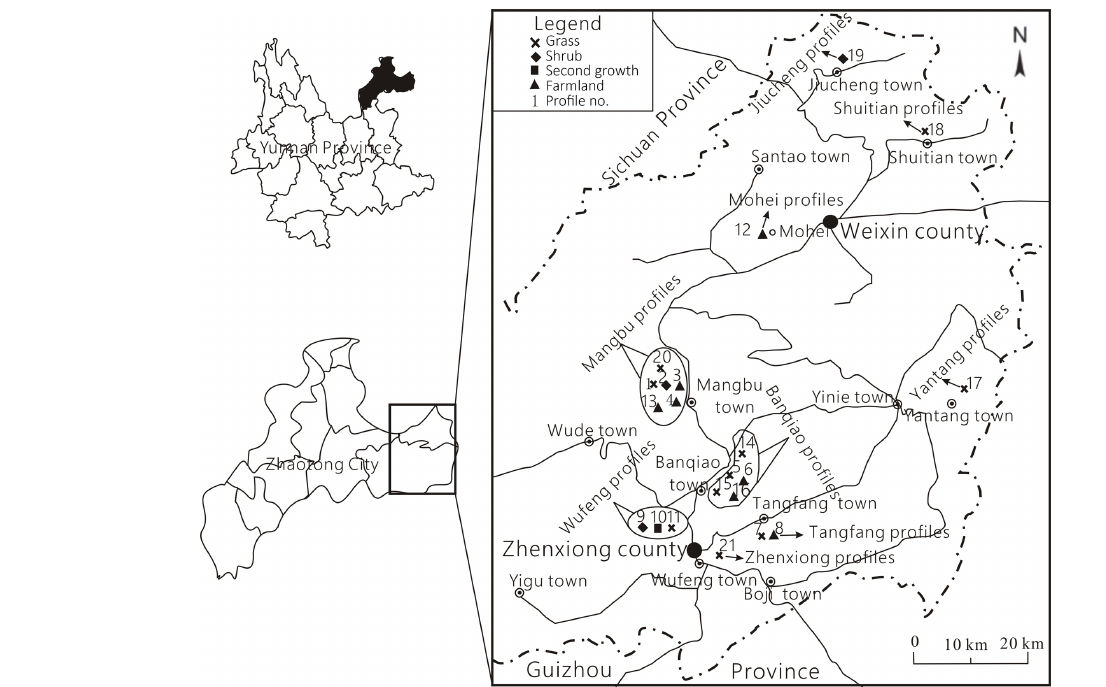
Figure 1. Sites for measuring soil CO 2 and gathering organic carbon samples (1 is Mangbu O 2 − 3 grass, 2 is Mangbu O 2 − 3 shrub, 3 is Mangbu O 2 − 3 farmland, 4 is Mangbu O 2 − 3 farmland, 5 is Banqiao O 1 m grass, 6 is Mangbu O 1 m farmland, 7 is Tangfang P 2 c grass, 8 is Tangfang P 2 c farmland, 9 is Wufeng P 2 l shrub, 10 is Wufeng P 2 l second growth, 11 is Wufeng P 2 l grass, 12 is Mohei P 2 l farmland, 13 is Mangbu O 2 − 3 farmland, 14 is Banqiao P 2 c grass, 15 is Banqiao P 1 m(q) grass, 16 is Banqiao P 1 m(q) shrub, 17 is Tangfang P 2 β grass, 18 is Shuitian T 2 g shrub, 19 is Jiucheng T 3 x shrub, 20 is Mangbu O 1 m grass, and 21 is Zhenxiong T 1 f grass). Table 1. Regression analysis of soil CO 2 concentration and profile depth in noncarbonate areas. Profiles Regression equation R 2 P Wufeng P 2 l shrub